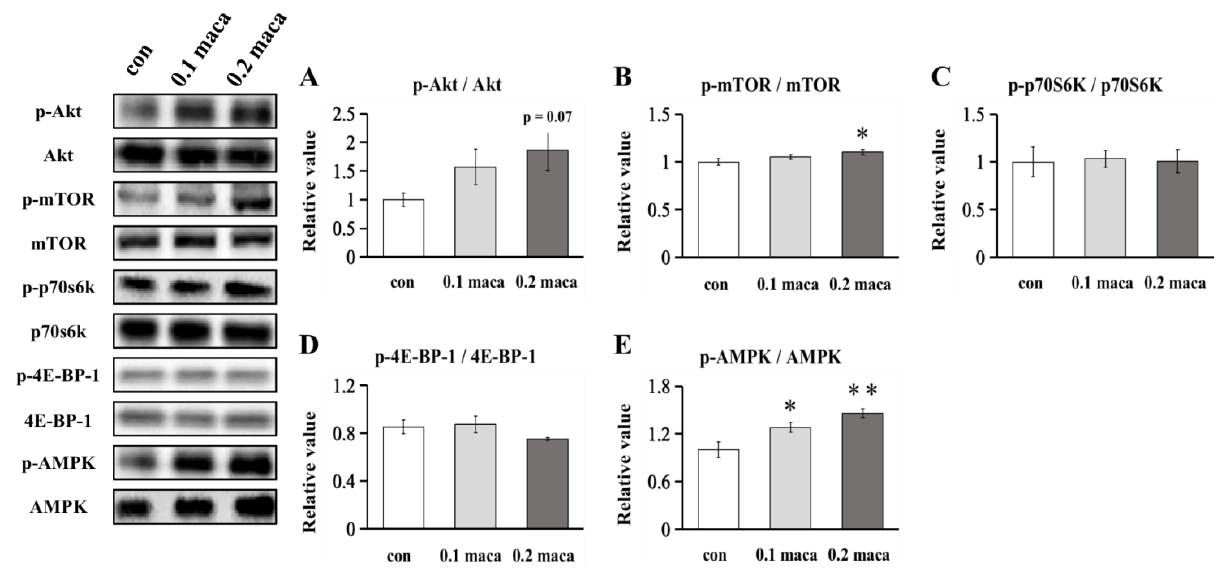
Figure 3. Protein expression in C2C12 myotubes. Representative immunoblots are shown on the left side, and the quantification of Akt ( A ), mTOR ( B ), p70S6K ( C ), 4E-BP-1 ( D ) and AMPK ( E ) phosphorylation was compared between the con group and maca groups. * p < 0.05 vs. con; ** p < 0.01 vs. con.